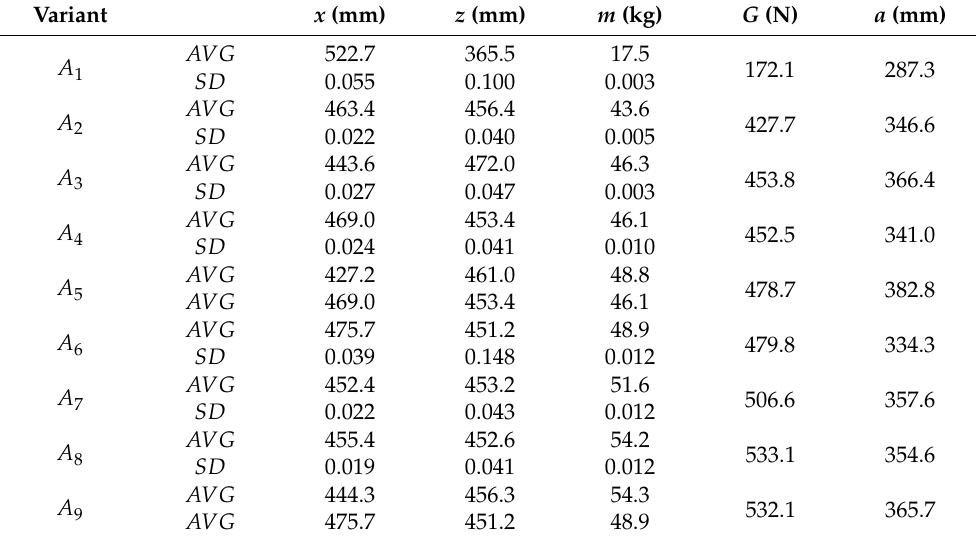
Table 2. Measurement results for individual variants and calculated values of variable parameters in the simulation; 𝐴𝑉𝐺 —arithmetic mean, 𝑆𝐷 —standard deviation.